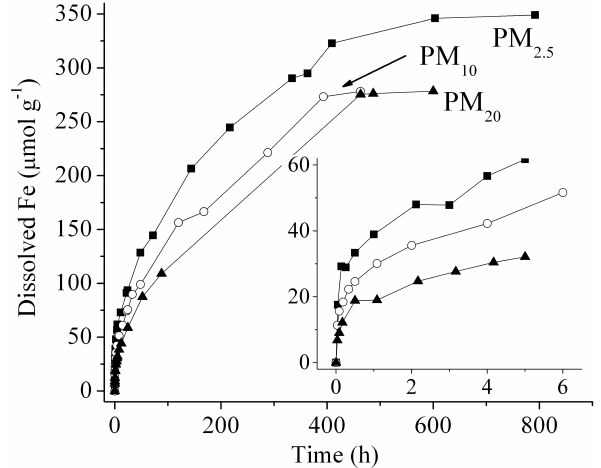
Fig. 1. Fe dissolution kinetics in Tibesti-PM 20 , -PM 10 and -PM 2 . 5 at pH 1 and at a dust/liquid ratio of 60mgL − 1 . The inset shows the results from the first 6h of the experiments in more